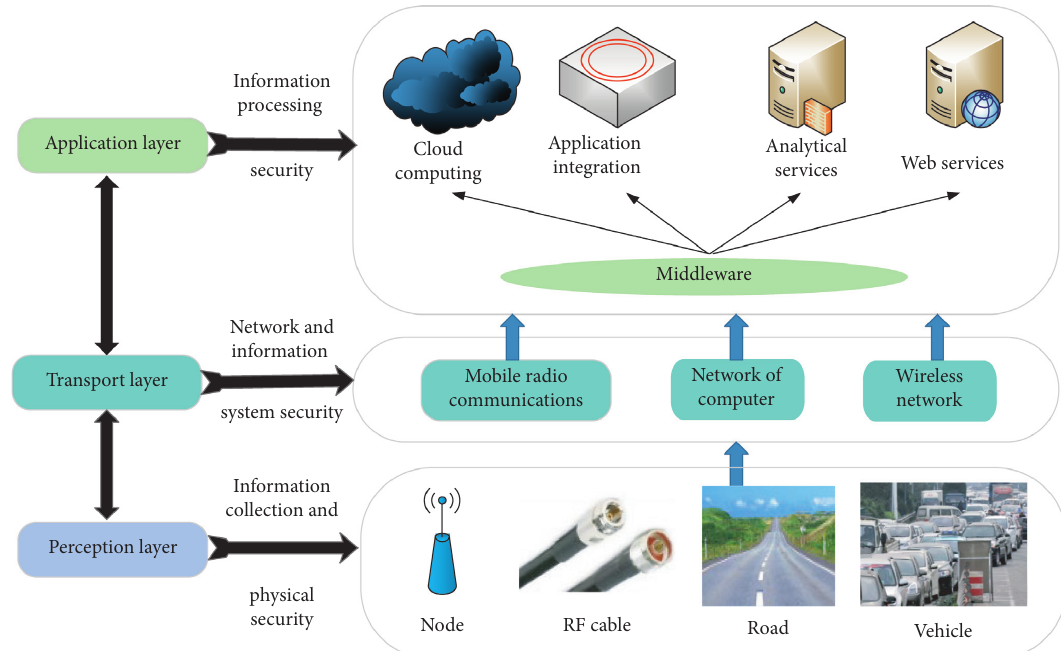
Figure 2: A schematic diagram of the architecture framework of the IoT system in the construction of intelligent